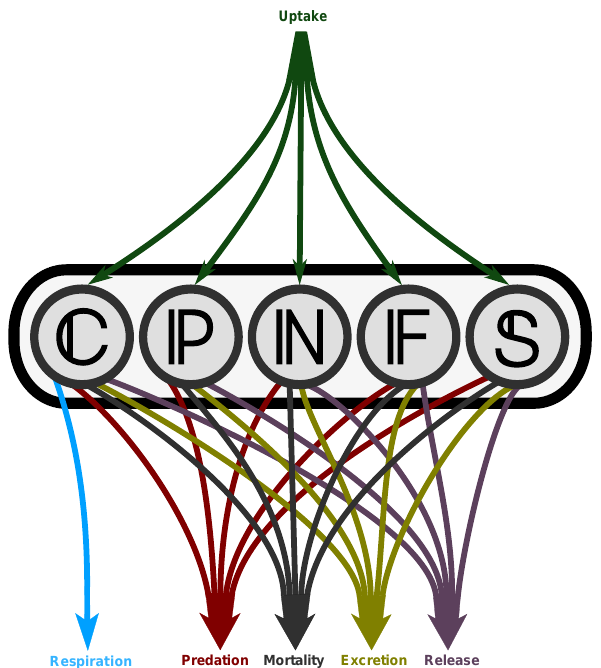
Figure 1. Generic processes acting on the chemical components of the ERSEM standard